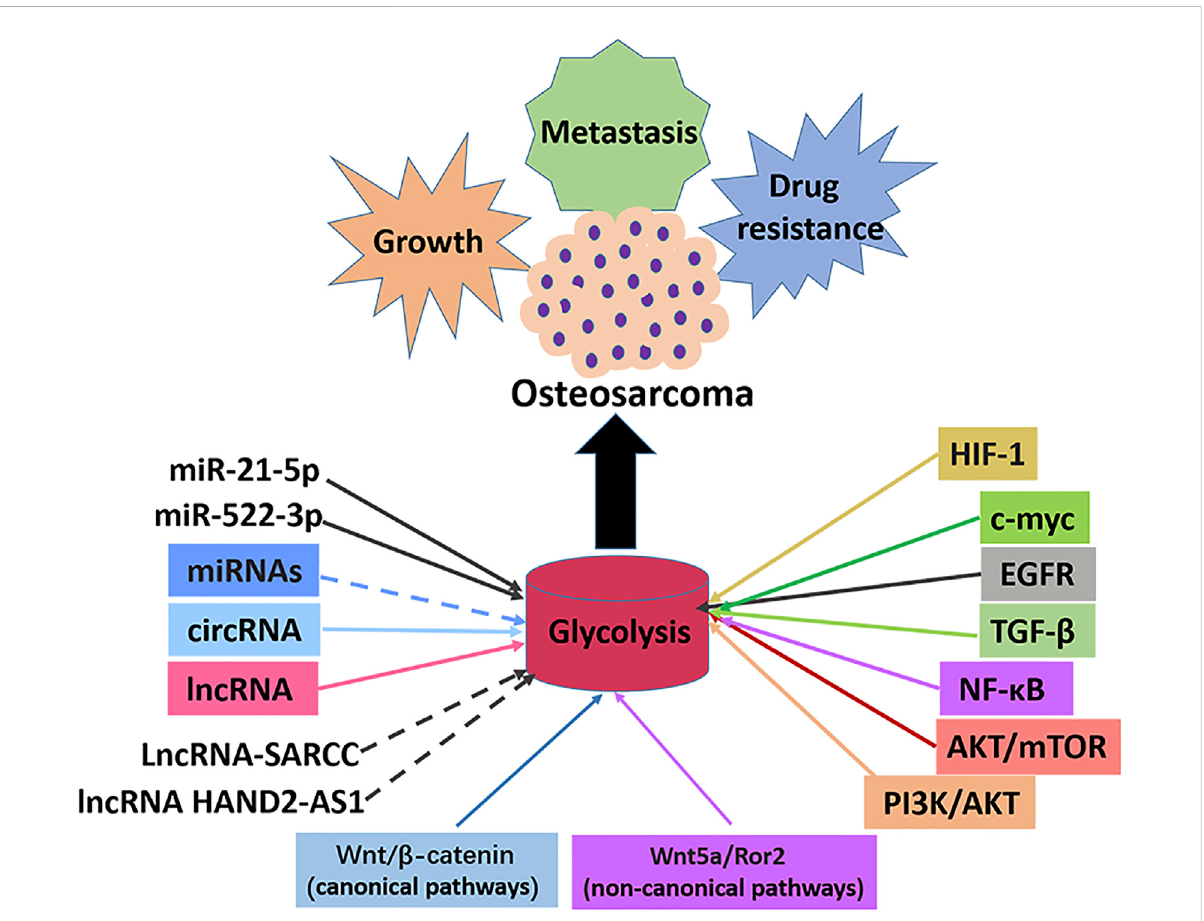
FIGURE 4 Signal pathways, transcription factors and ncRNAs that regulate glycolysis in osteosarcoma. The enhancement of glycolysis in osteosarcoma promotes the malignant behaviors such as proliferation, metastasis and drug resistance of osteosarcoma cells. Most miRNAs inhibit the progression of osteosarcoma by inhibiting glycolysis, with the exception of miR-21-5p and miR-522-3p. Most lncRNAs promotes the progression of osteosarcoma by promoting glycolysis, with the exception of lncRNA-SARCC and lncRNAHAND2-AS1. All circRNAs promote osteosarcoma progression by promoting glycolysis. Transcription factors c-myc and HIF-1 α promote glycolysis and osteosarcoma progression. Signal pathways PI3K/AKT, AKT/mTOR, NF- κ B, TGF- β , EGFR, Wnt/ β -catenin, Wnt5a/Ror2 promote glycolysis pathway and osteosarcoma